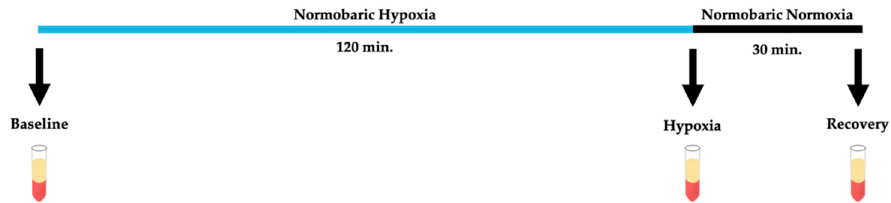
Figure 1. Time course of experimental setup for hypoxic intervention. Participants were exposed to 120 min of normobaric hypoxia followed by 30 min of normobaric normoxia. Each arrow indicates a time point (“Baseline”, “Hypoxia”, and “Recovery”) where peripheral blood samples were withdrawn from a forearm vein.